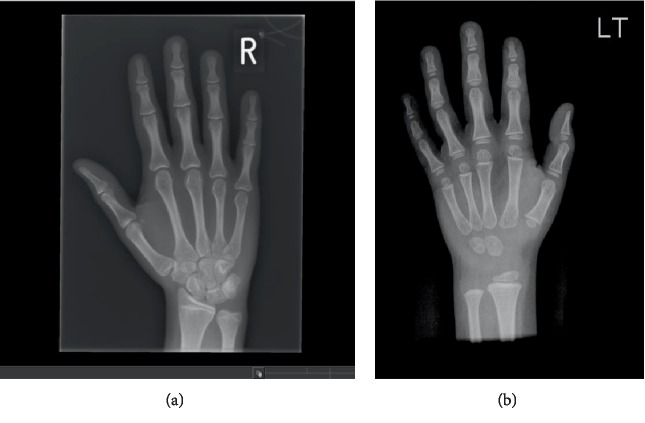
(a and b) B1 radiograph of right hand aged 15 years (a). B1 radiograph of right hand aged 3 years (b).